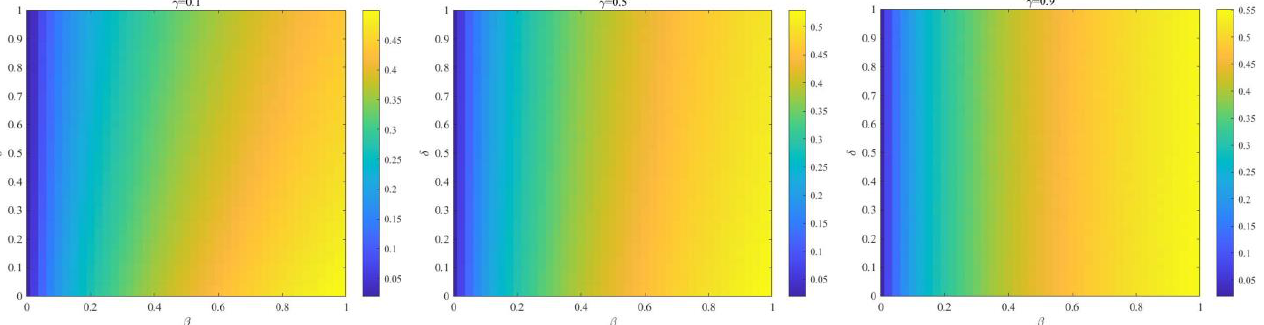
Figure 12. The full-phase diagram δ − β for different values of γ . The color represents the proportion ρ R of recovered enterprise under steady state, other parameters are set as α = 5, m = 2, m 1 = 5, m 2 = 7, κ = 2, η = 0.8, µ = 0.8, λ = 0.8, θ = 0.3, p = 0.5, q =